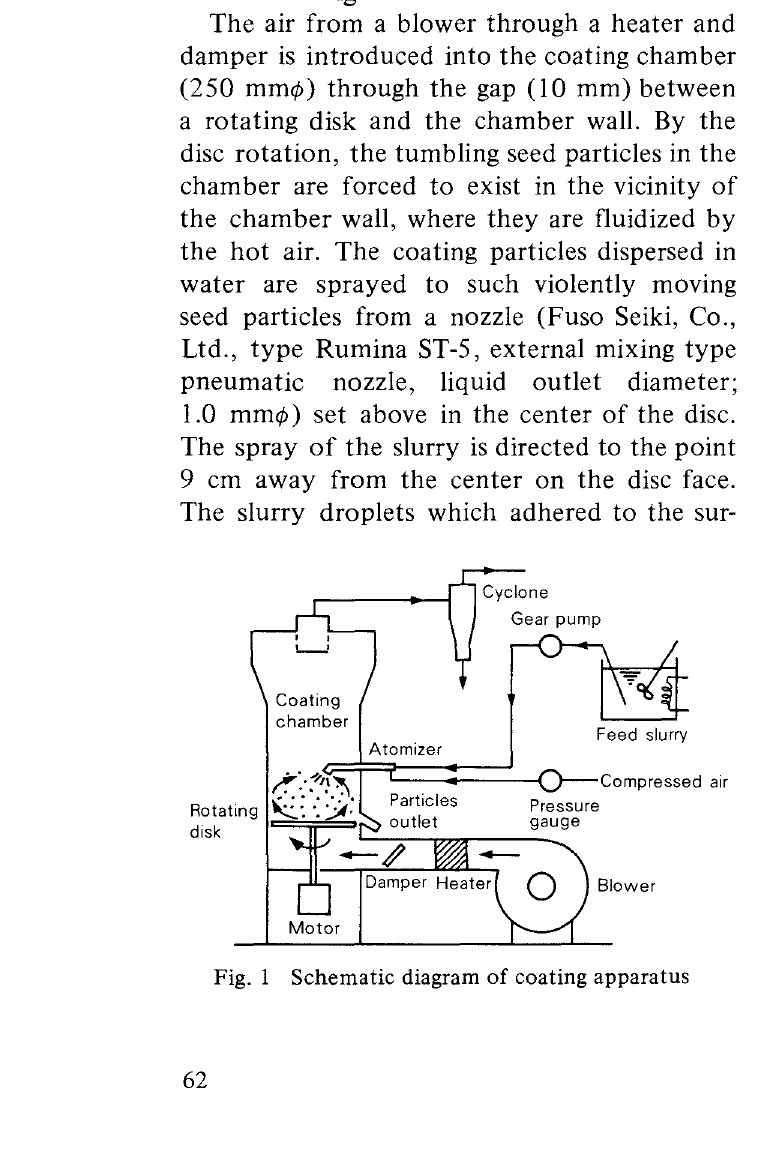
Fig. 1 Schematic diagram of coating